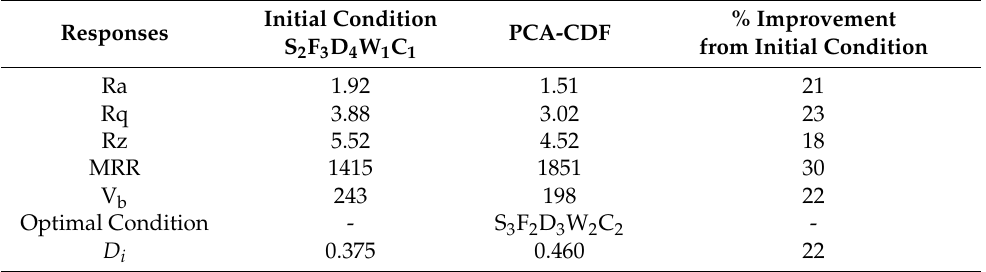
Table 12. Comparative summary of confirmatory